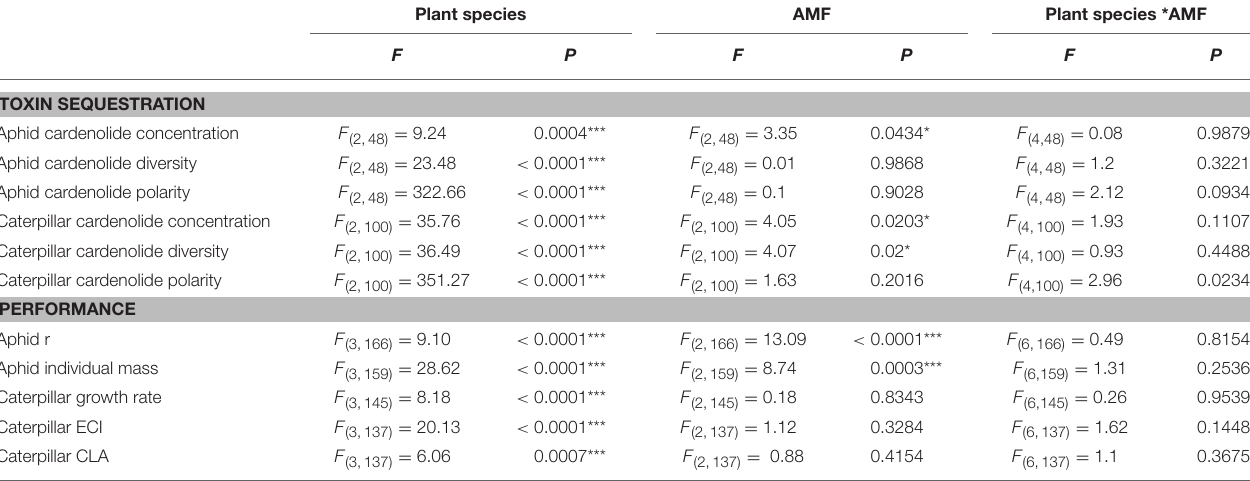
TABLE 2 | Effects of plant species, arbuscular mycorrhizal fungi (AMF) inoculum availability, and their interaction on measures of herbivore toxin sequestration and performance, including natural log-transformed cardenolide concentration sequestered by aphids (mg/g dry mass), diversity of cardenolides sequestered by aphids, natural log-transformed polarity of cardenolides sequestered by aphids, natural log-transformed cardenolide concentration sequestered by caterpillars (mg/g dry mass), diversity of cardenolides sequestered by caterpillars, natural log-transformed polarity of cardenolides sequestered by caterpillars, aphid per capita growth rate (r), individual aphid dry mass ( µ g), caterpillar growth rate (mg/day), log-transformed caterpillar efficiency of conversion (ECI) of ingested biomass, and log-transformed leaf area consumed (CLA) by caterpillars (cm 2